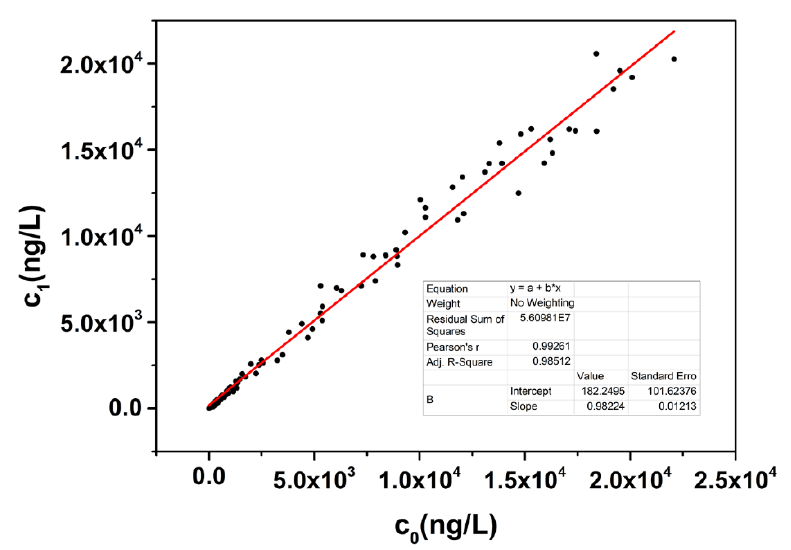
Figure 5. Correlation between results measured using the commercially available Roche NT-proBNP diagnostic kit (c 0 ) and the proposed chemiluminescence diagnostic reagent (c 1 ). Y = 0.9322X + 182.2 (r = 0.985, p < 0.001).